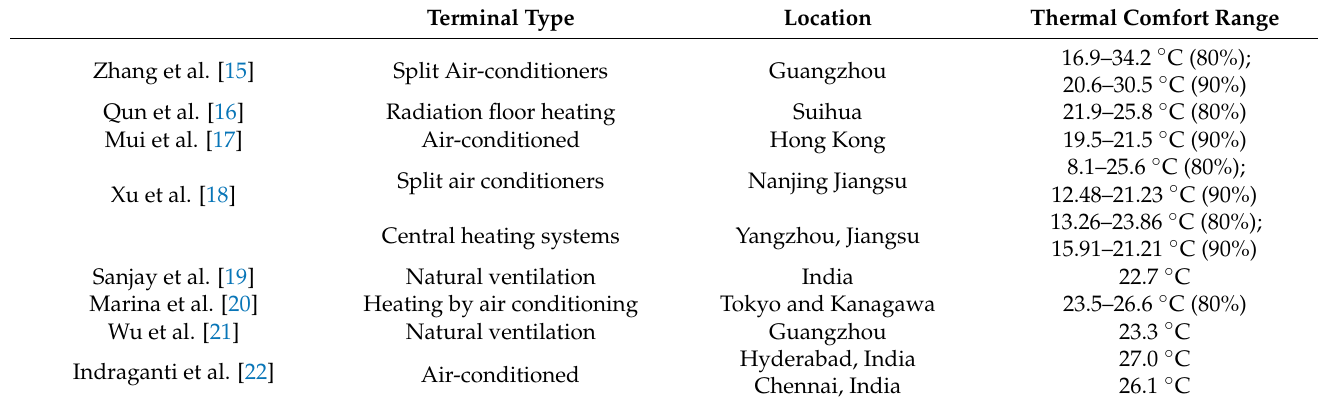
Table 1. Research findings of various heating terminals’ thermal comfort